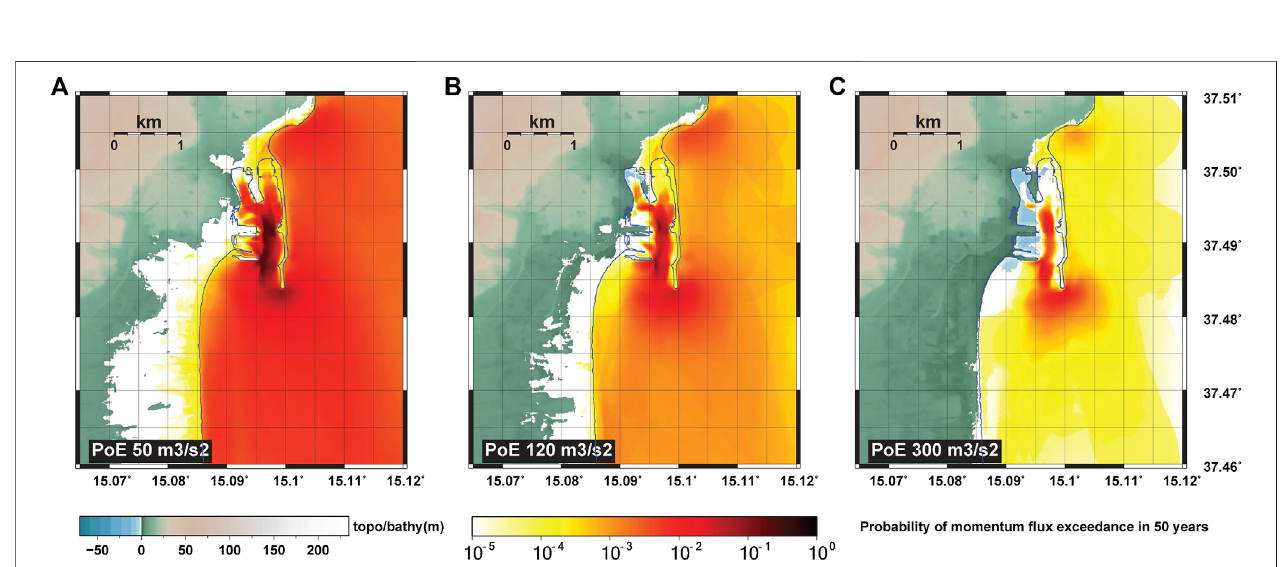
FIGURE10| Probabilityofexceedancewithin50yearsofmaximummomentum fl uxof (A) 50 m 3 /s 2 (B) 120 m 3 /s 2 ,and (C) 300 m 3 /s 2 ,forCataniaandneighboring areas. The zero-elevation contour line for the undeformed topography is shown in blue.